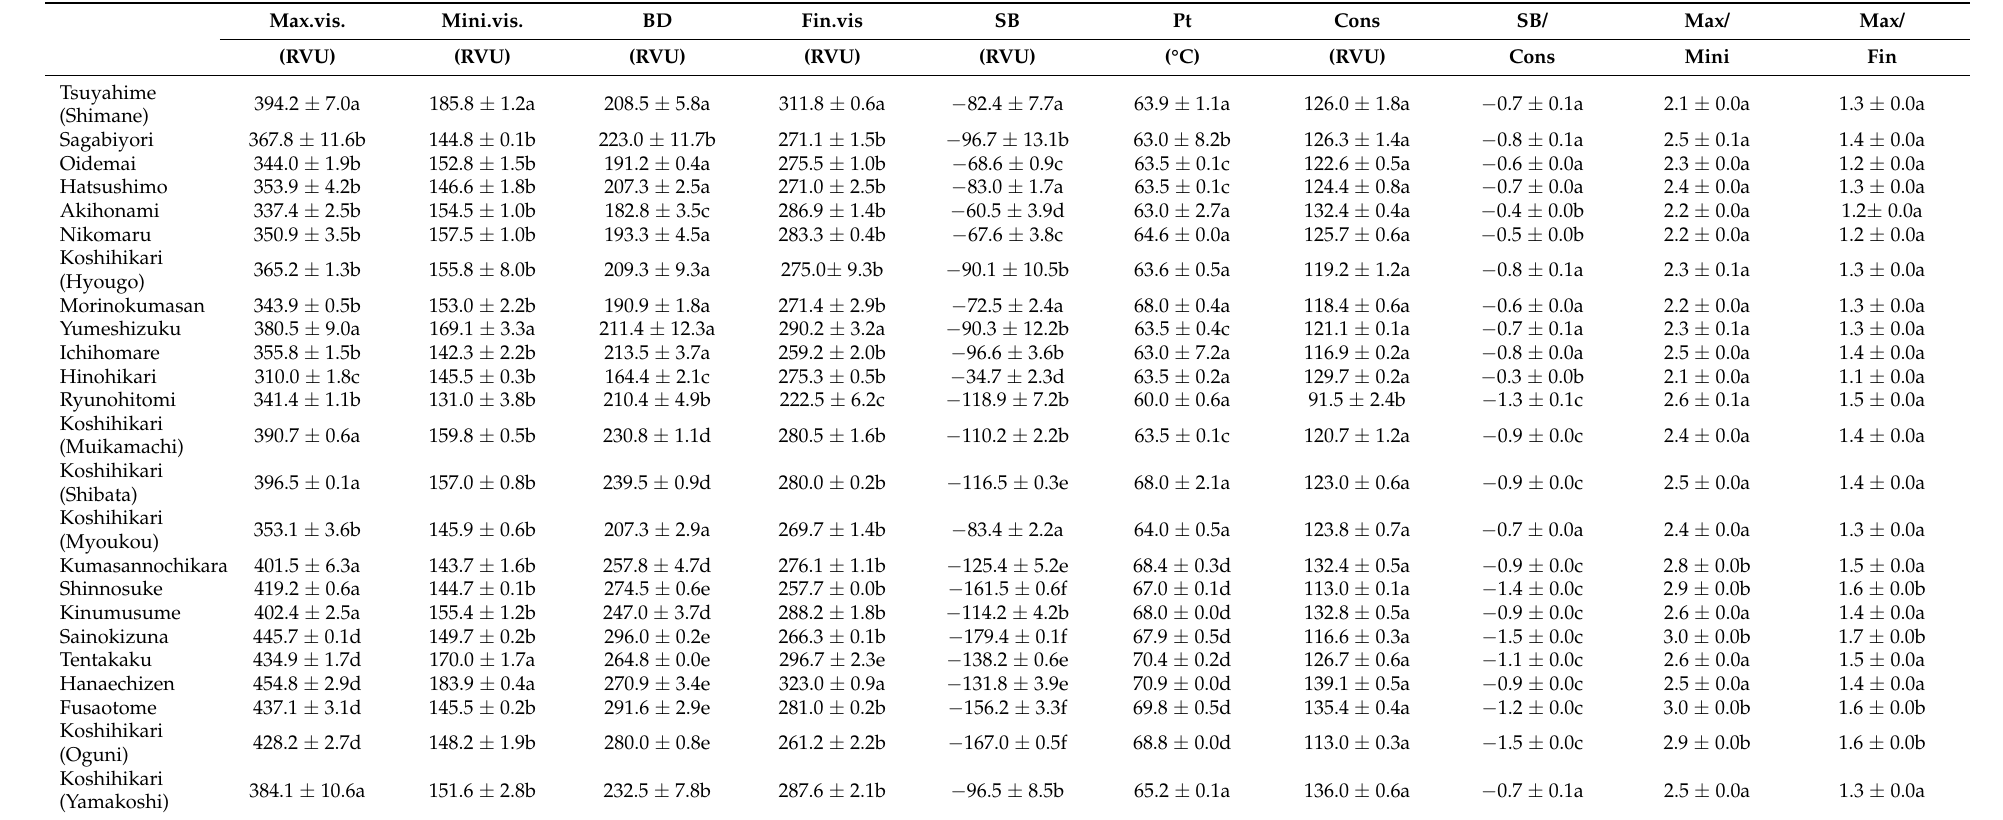
Table 1. Pasting properties of Japonica polished rice by RVA in